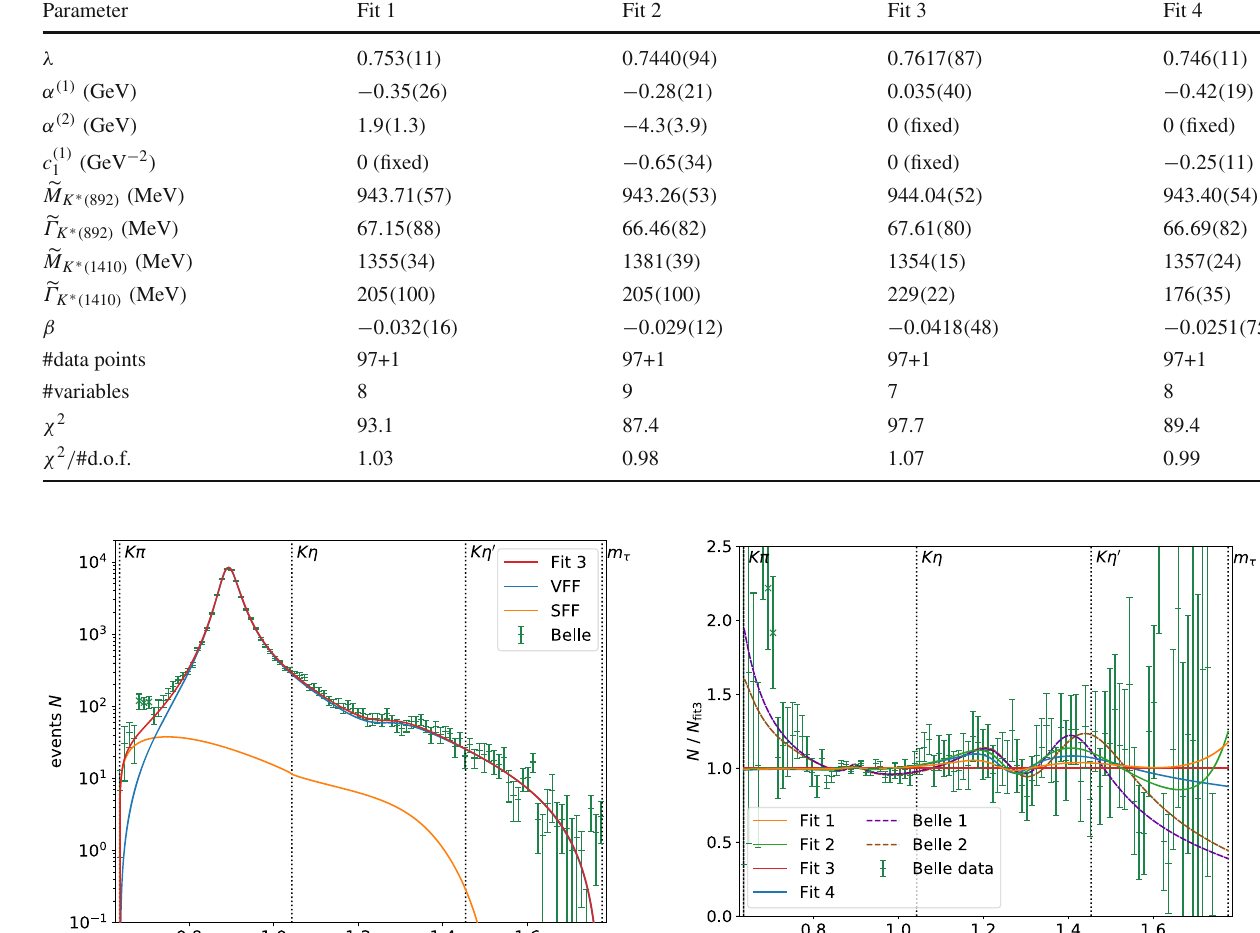
Table 3 Parameters of the fits of theoretical events N , defined in Eq. (23), to efficiency-corrected and background-reduced events for τ − → K π − ν τ [65] including the additional constraint of Eq. (33) S